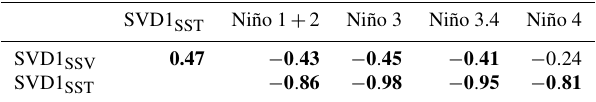
Table 1. Pairwise correlation coefficients between SVD1 SSV , SVD1 SST , and the Niño indices (described in Sect. 2.3). Correla- tions that are significant at the 95% confidence level are indicated in